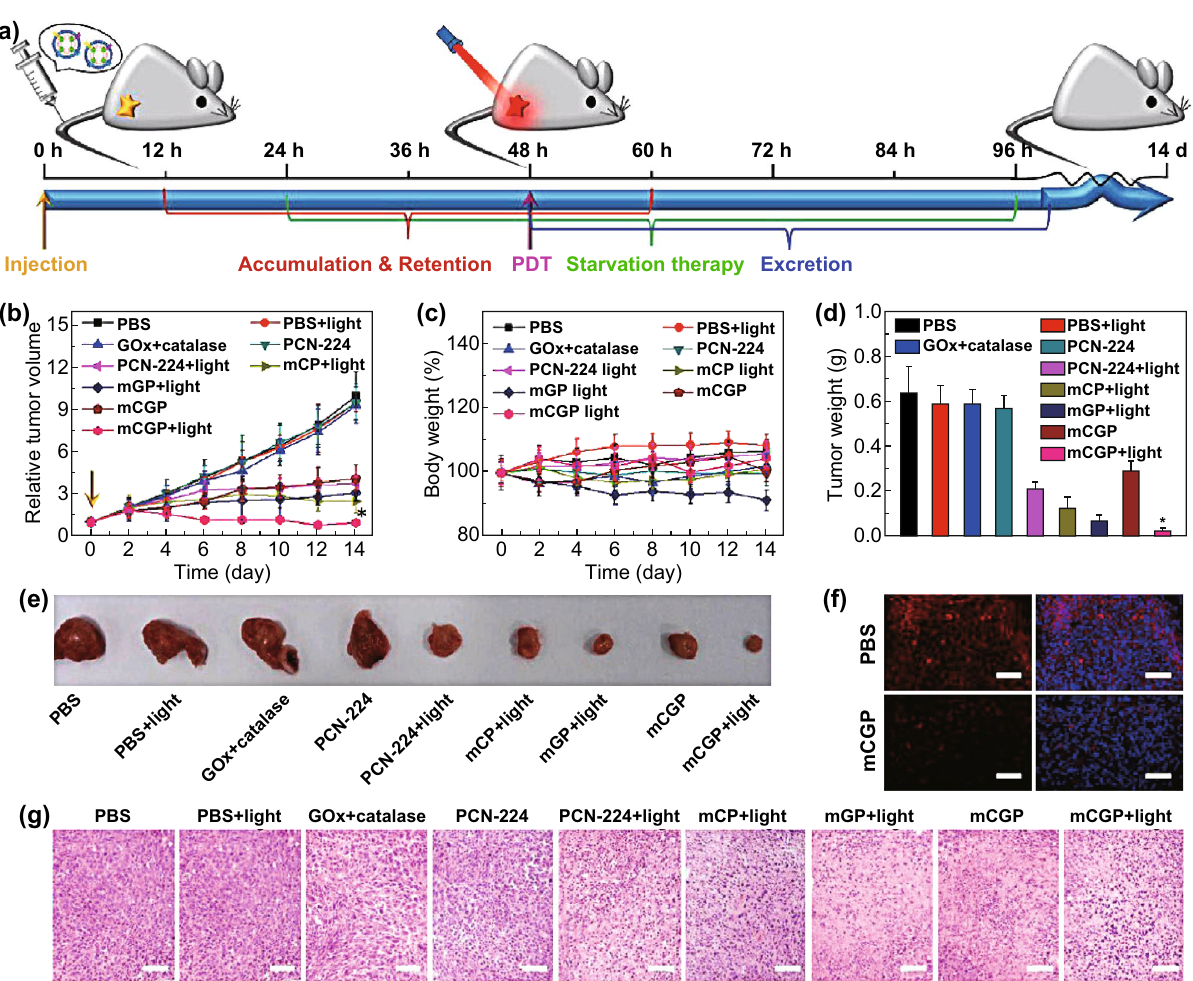
Fig. 13 In vivo mCGP anti‑tumor efficacy. a Overview schematic of the approach to combination PDT/tumor starvation achieved via mCGPs. b Tumor volumes and c changes in body weight 14 days following indicated treatments, *p < 0.05. Arrows correspond to therapeutic adminis‑ tration. d Average tumor weight and e representative images following 14 days of indicated treatments. *p < 0.05. f Immunofluorescent HIF‑1a staining following PBS or mCGP treatment. g H&E stained tumor sections on day 14 in differently treated mice. Scale bar = 200 μm. Adapted from Ref. [145] with